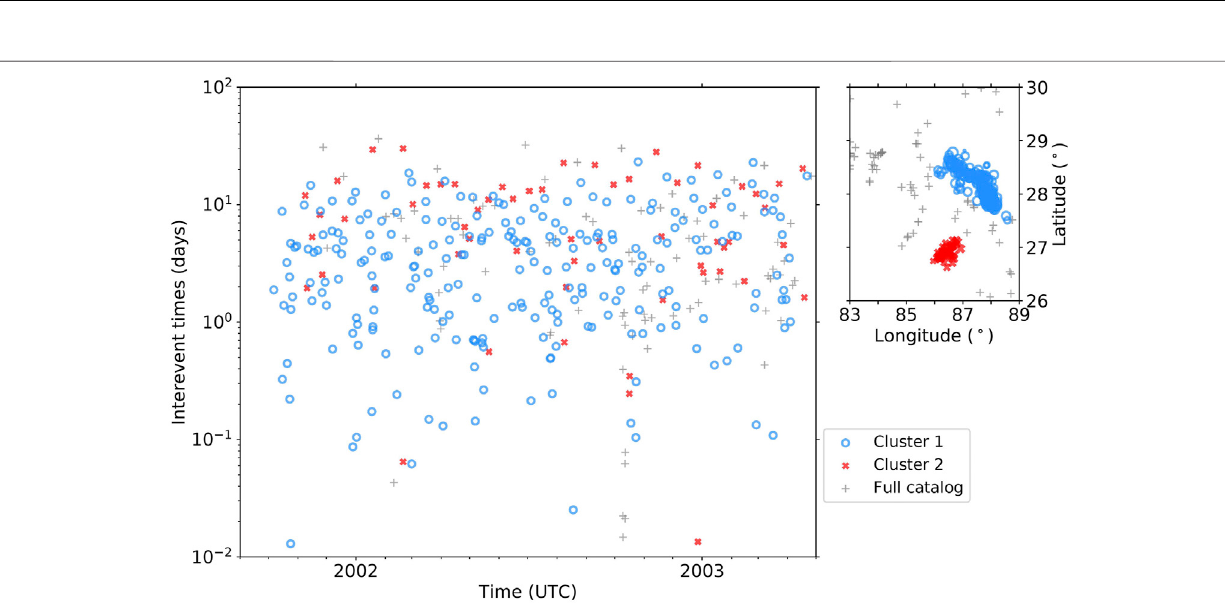
Frontiers in Earth Science |